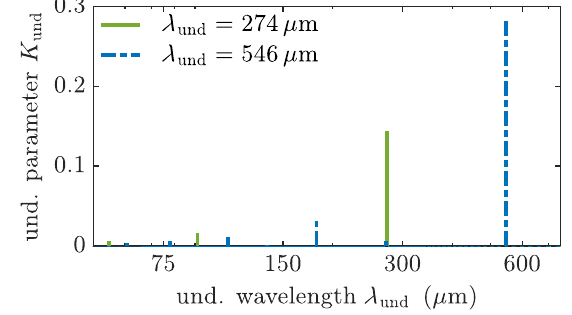
FIG. 11. Fourier analysis of the reference trajectory x 0 ð z Þ in order to determine the contributing oscillation wavelengths λ and the effective undulator parameter K DLA undulator lattices.